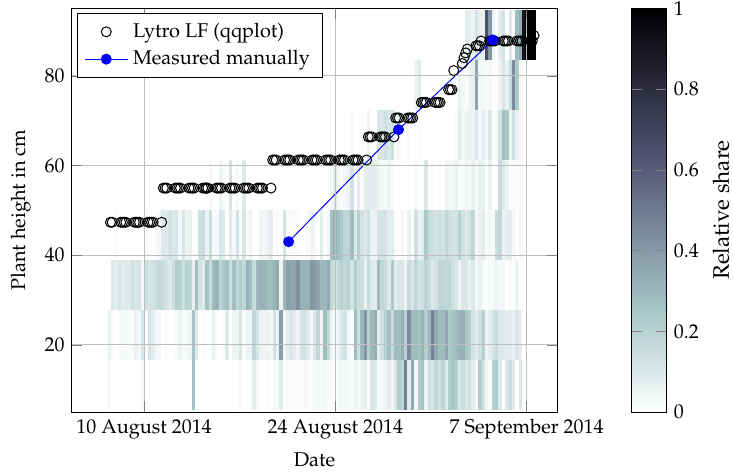
Figure 15. Comparison of manually-measured plant heights and Lytro LF depth estimation plus a temporal plot of plant height distribution (histogram bin counts) during the field